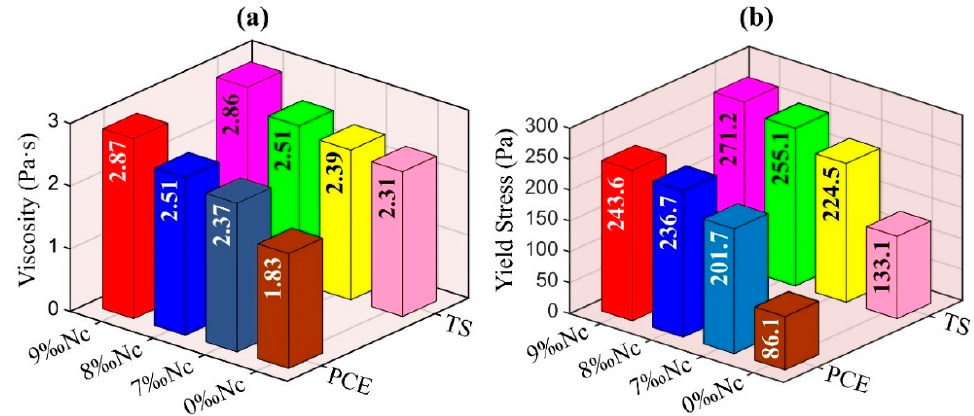
Figure 7. Rheological parameters ( a ) Viscosity and ( b ) Yield